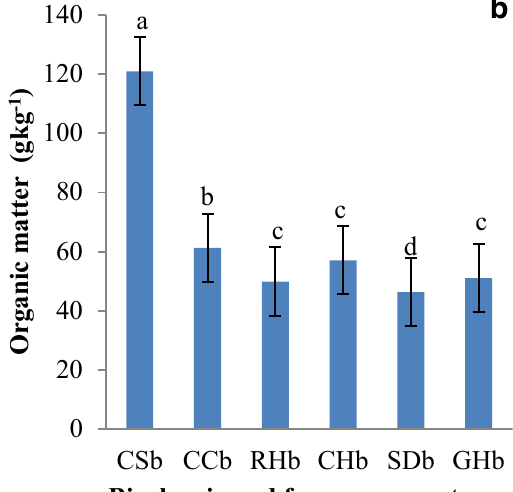
Fig. 4 Total carbon ( a ) and organic matter ( b ) content biochar issued from crop waste. The letters in superscript compare the mean ± SD of the treatments. The same letters on a bar are not significant according